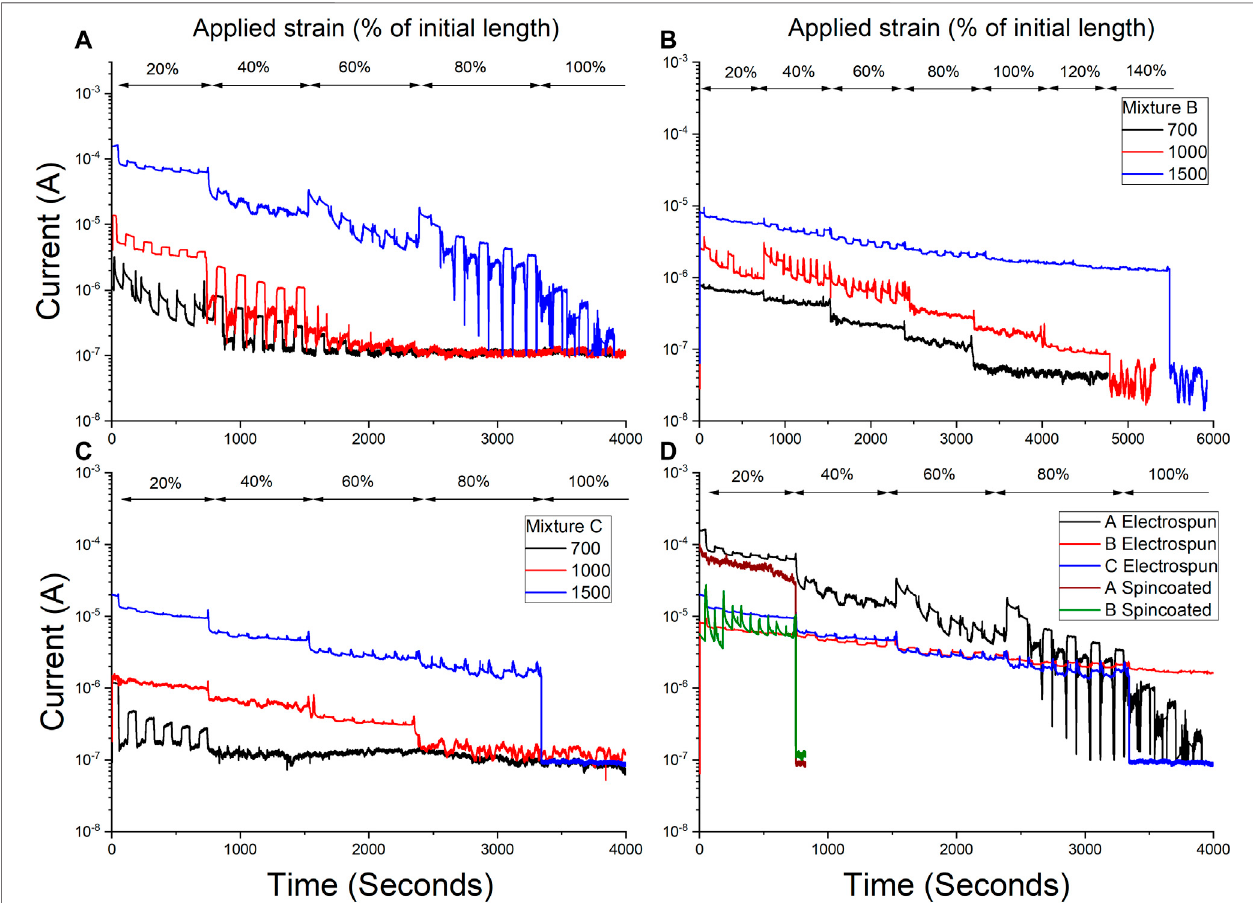
FIGURE5| CurrentasafunctionoftimeforPEDOT:Tos fi bers:MixturesA (A) ,B (B) andC (C) onPDMSwithdifferentelectrospinningtimes:700( ▬ ),1,000( ▬ )and 1,500 s( ▬ ). (D) Current vstimefor electrosposun samples: Mixtures A ( ▬ ),B( ▬ ) and C ( ▬ ) for 1,500 sand spincoated samples on pre-strained PDMS: Mixtures A ( ▬ ) and B ( ▬ ). The samples were stretched between 20 and 100% strain at 0.1 cm/s. Five consecutive stretching/release cycles were done for each strain between 20 and 100%. The samples were kept in each state (stretched or released) for a resting time of 1 min.